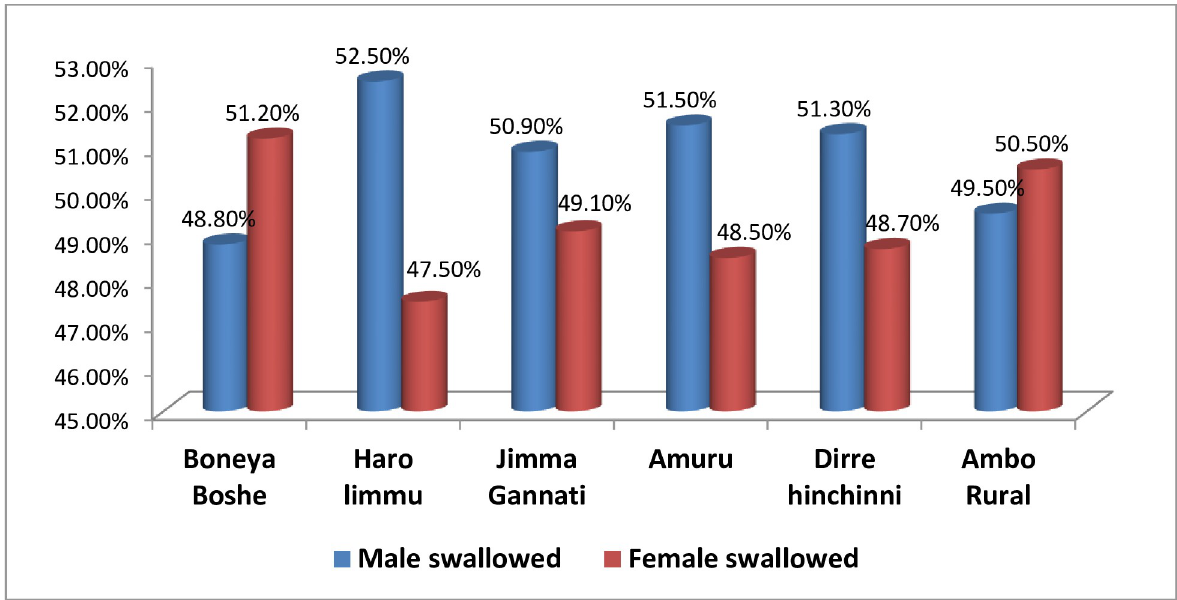
Fig 3. Proportion of respondents swallowed drugs by sex, mass drug administration for Trachoma coverage survey in six districts in East Wollega, Horroguduru Wollega, and West Shewa zones, 2017.